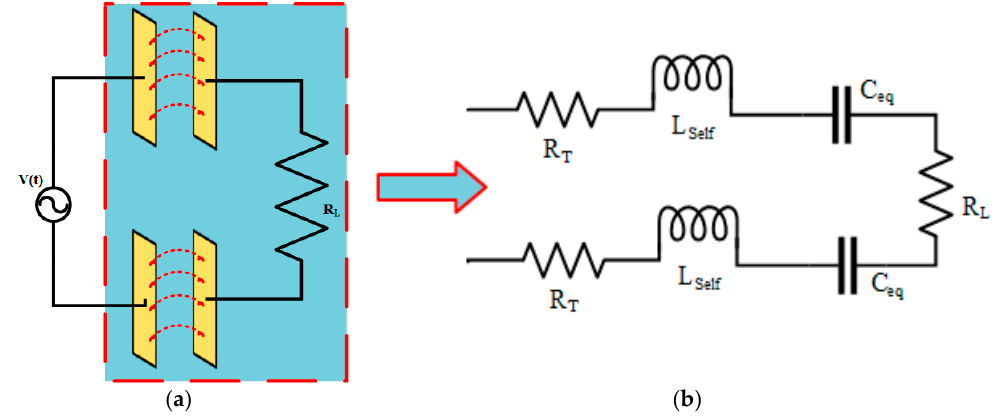
Figure 2. ( a ) Schematic diagram of CCWPT; ( b ) equivalent circuit of CCWPT.